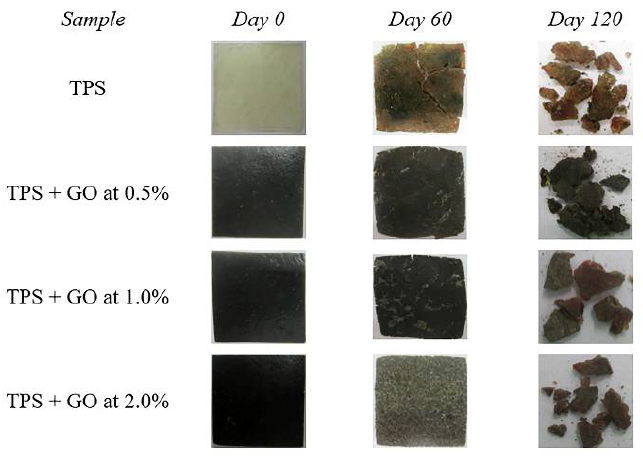
Figure 8. Photographs of TPS/GO samples submitted to soil burial biodegradation tests.